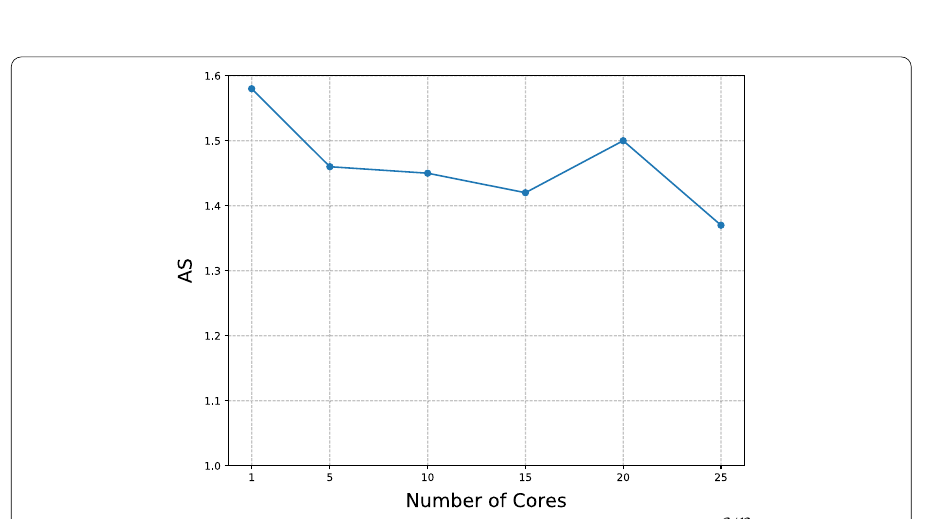
Fig. 11 Algorithmic speedup analysis for lyon-road-network graph in parallel mode- AS E / B p =[ 1,5,10,15,20,25